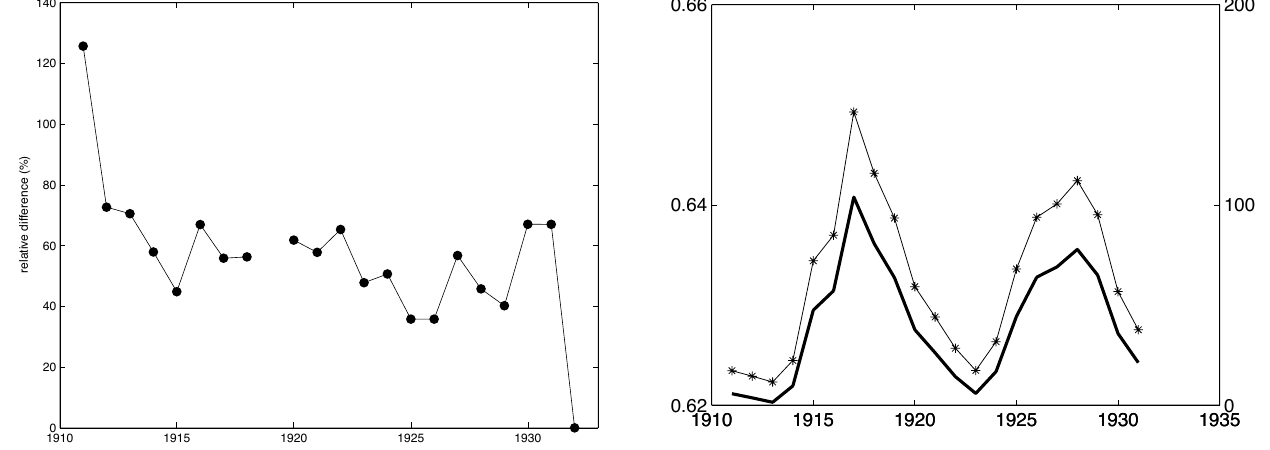
Fig. 4. The CF-raw correction factors for ESK IHV-raw (thin line with stars, left axis) and sunspot numbers (thick line, right axis) in 1911–1931.